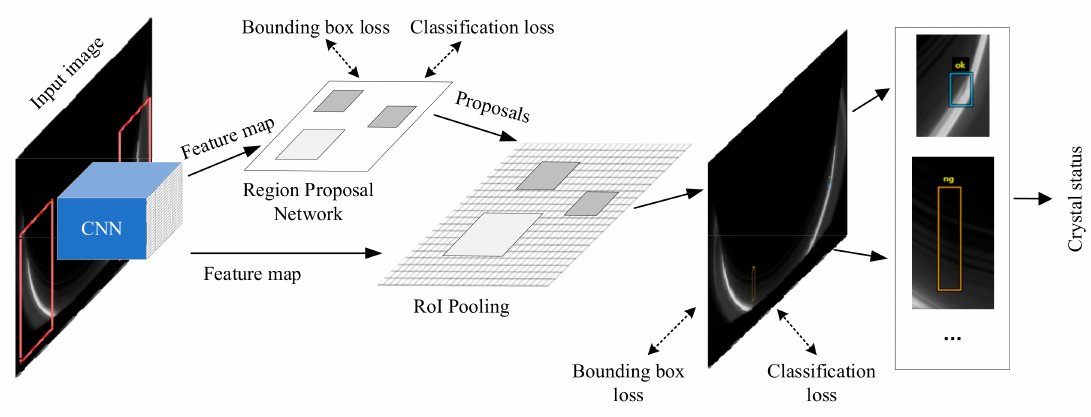
Figure 7. The detection